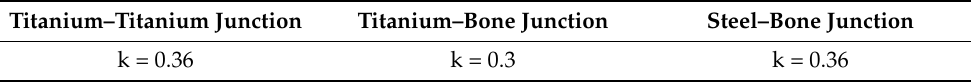
Table 2. Friction coefficients for junctions.